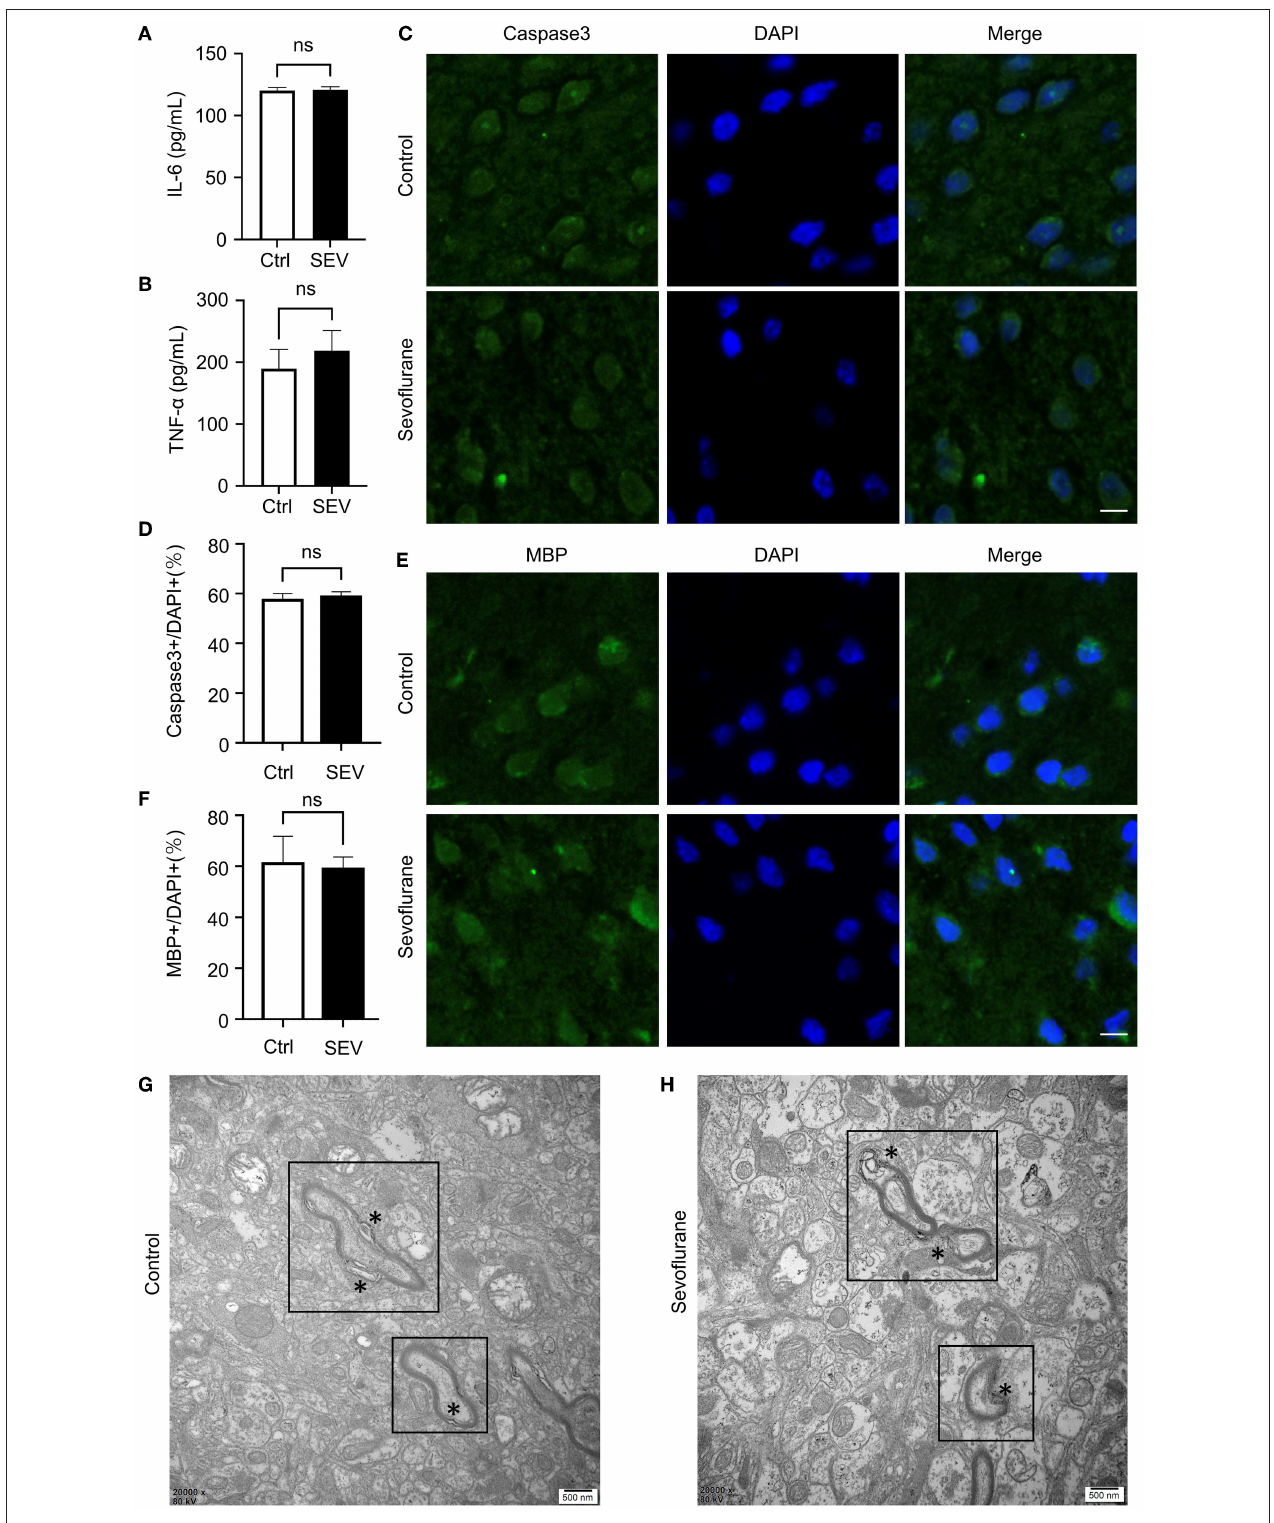
FIGURE 1 | The effect of sevoflurane anesthesia on the biomarkers of neural injury in the prefrontal cortex (PFC) of aged marmosets. (A,B) Elisa analysis indicated the amounts of IL-6 ( n = 3, 120.1 ± 2.21 vs. 120.8 ± 2.25, p = 0.74, one-way ANOVA) and TNF- α ( n = 3, 189.3 ± 31.35 vs. 218.7 ± 21.47, p = 0.25, one-way